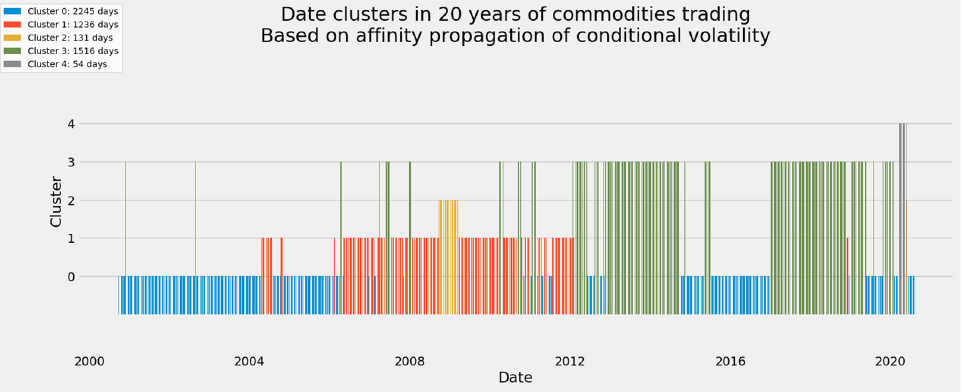
Figure 14. Affinity propagation of commodity markets—An ordered timeline.